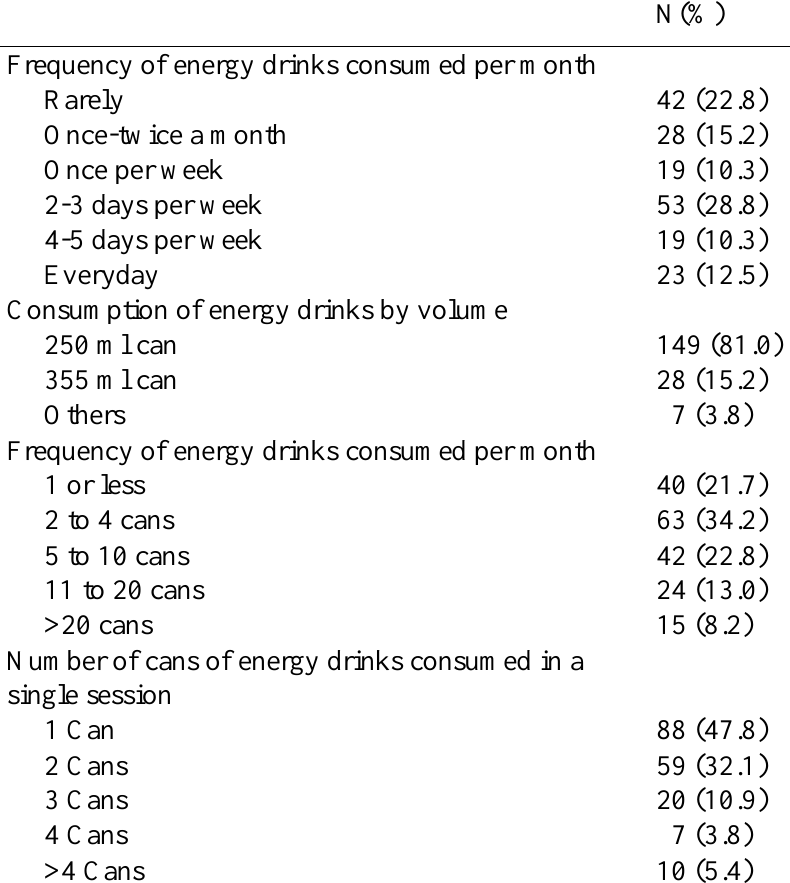
Table 2: Frequency and volume of energy drink